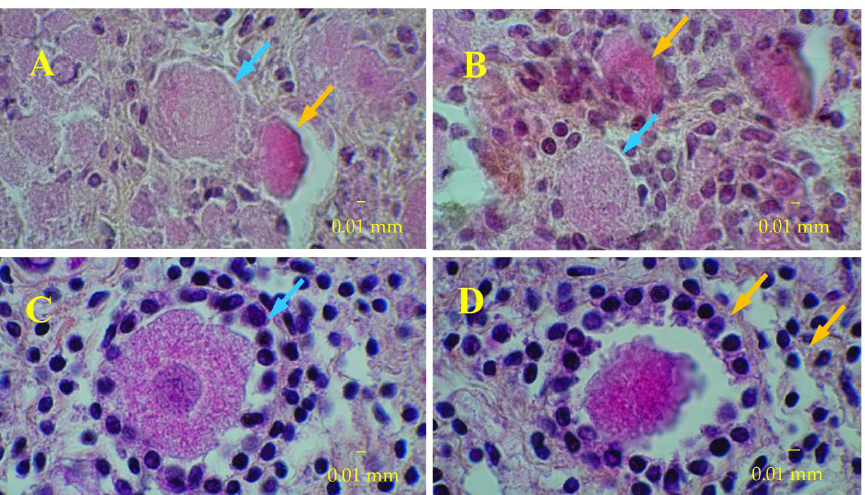
Figure 5. Fetal ovarian tissue in bioreactor at day 90. Slices colored with hematoxylin-eosin-safran. ( A ): primordial follicles. ( B ): primary follicles. ( C ): secondary follicle. ( D ): degenerated secondary follicle. Blue arrows indicate intact follicles. Orange arrows indicate degenerated follicles.